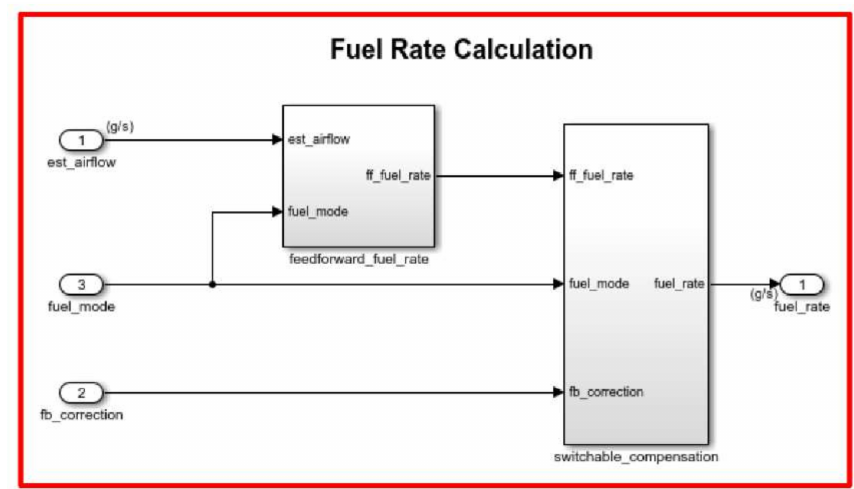
Figure 10. Fuel rate calculation block.